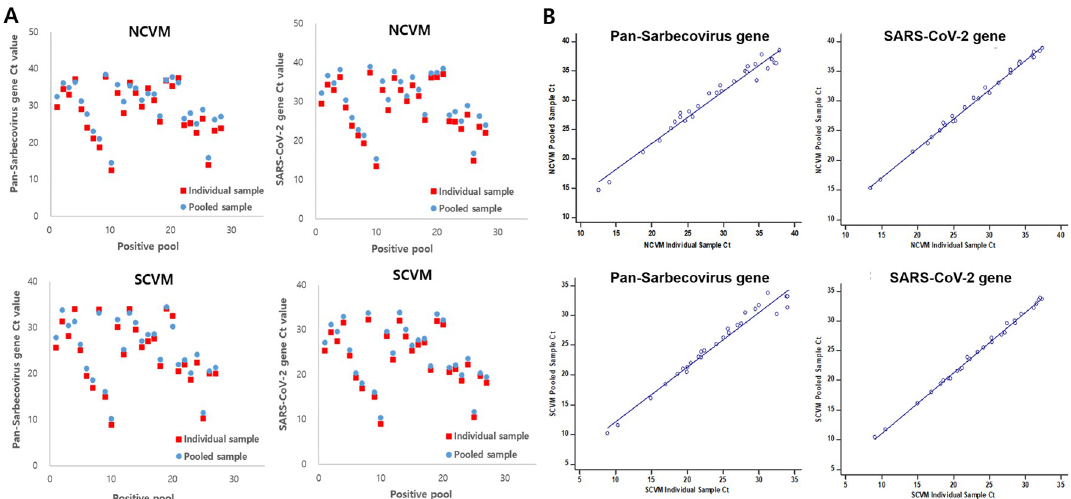
Fig 3. The comparison of Ct values in individual samples and pooled samples in NPS/OPS specimen pooling test. (A) Ct values of individual and pooled samples in the AccuPower 1 kits. (B) The regression analysis with Ct values in individual samples and pooled samples in the AccuPower 1